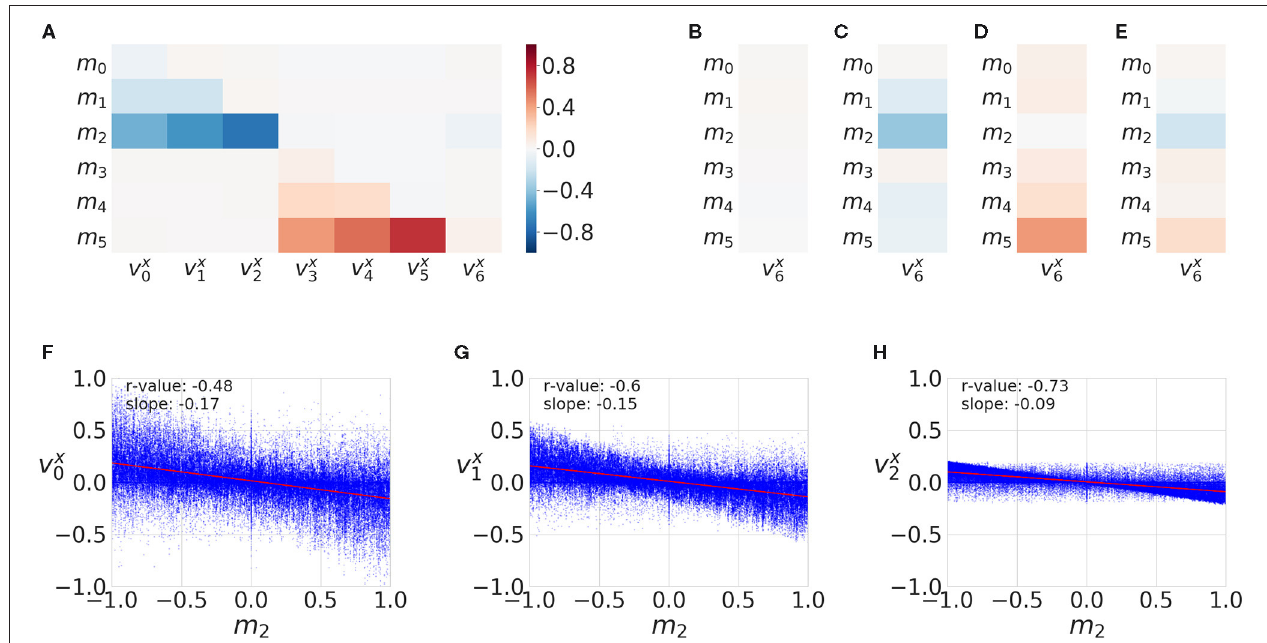
FIGURE 3 | Motor and sensory correlations. (A) Correlations matrix between motor activation ( m 0 ... m 5 signals) and SIP velocities v 0 , ..., v 6 , generated from 50,000 random SM interactions. (B) Correlation column of all motor activations with the object SIP velocity v x 6 for SM data when there is no contact (no haptic signals active) (C) Correlation of motors with object SIP velocity when there is contact between the lower (bottom) arm and the object. (D) Correlation of motors with object SIP velocity when there is contact between the upper arm and the object. (E) Correlation between motor and object SIP when there is contact between the object and either arm. (F–H) All data points and linear fit for m 2 and SIP velocities v x 0 , v x 1 , v x 2 . The r -values correspond to the equivalent correlation matrix color